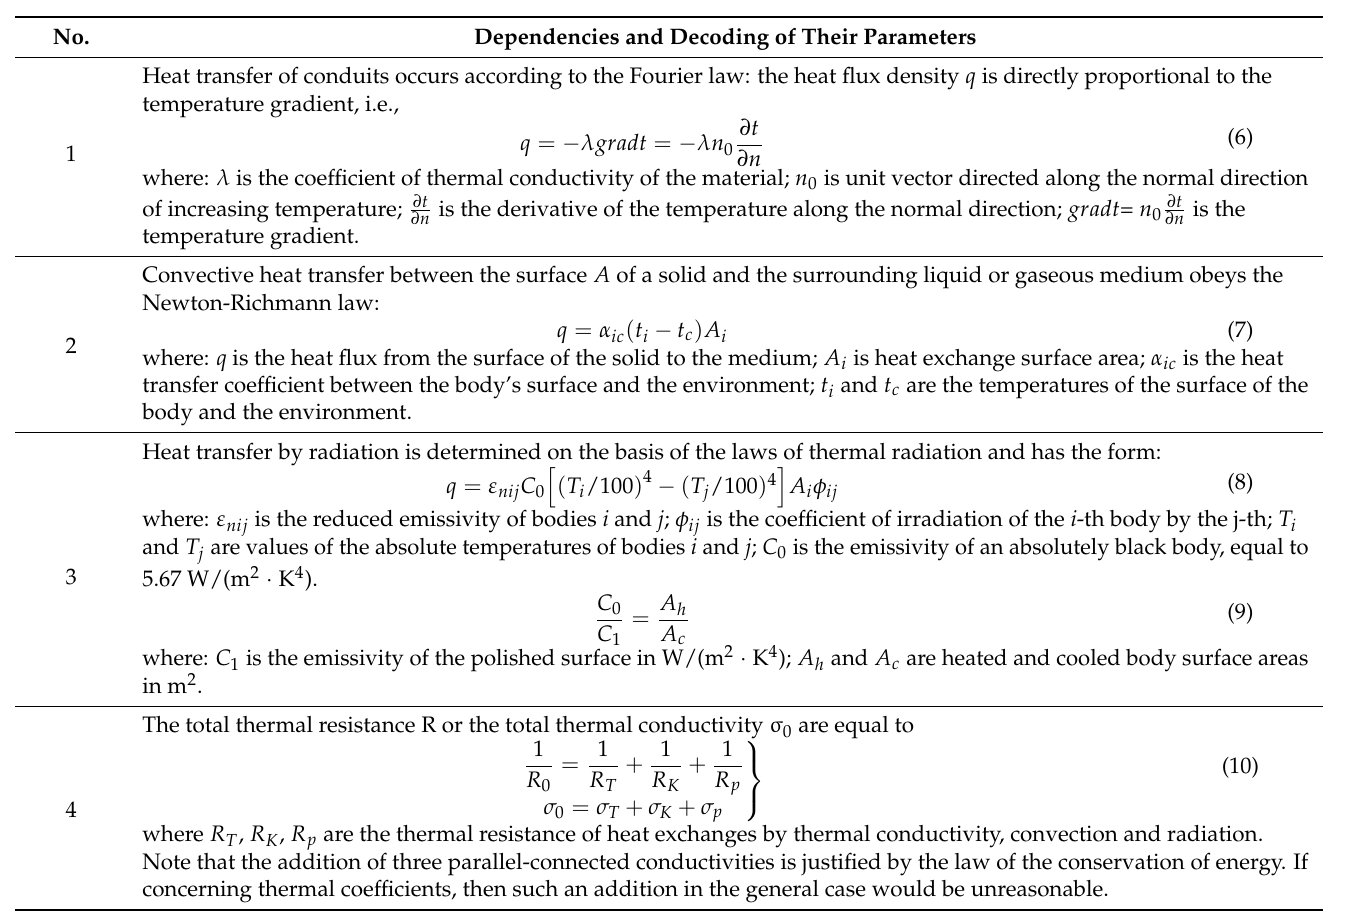
Table 2. Complex heat exchange between the body and